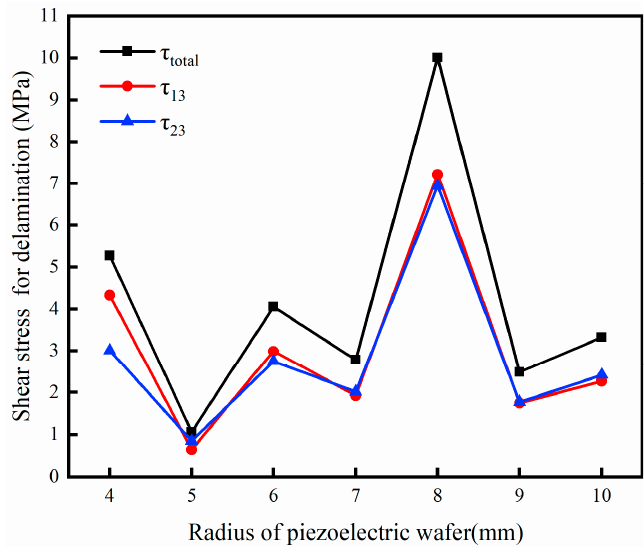
Figure 8. Shear stress for delamination of seven different configuration.